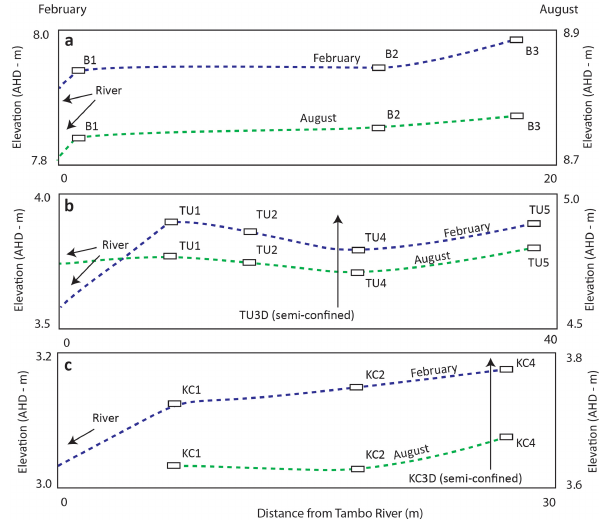
Figure 3. Groundwater elevations during February 2011 and Au- gust 2011 at Bruthen (a) , Tambo Upper (b) and Kelly Creek (c) . White rectangles – measured elevation; dashed lines – interpolated